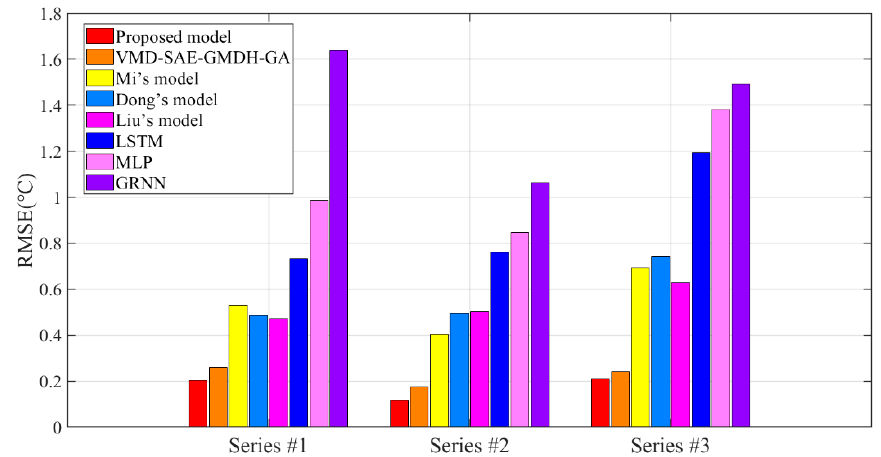
Figure 10. RMSE results of eight models.